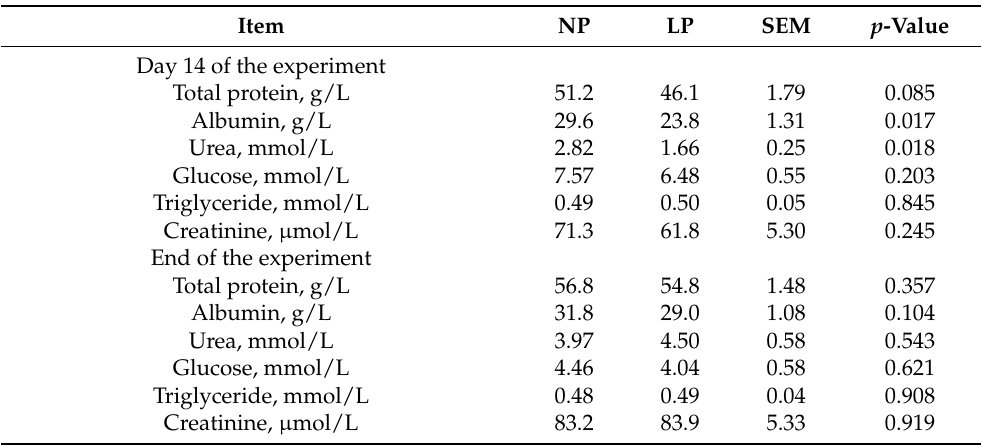
Table 4. Effects of protein restriction and realimentation on the serum biochemical parameters of piglets 1 .